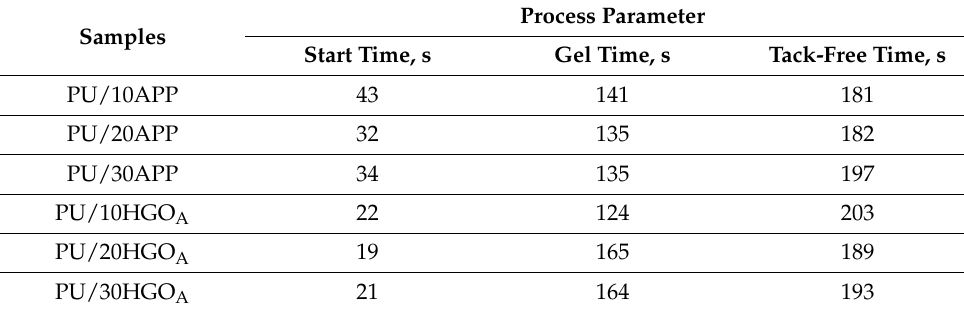
Table 2. Process times for PU/APP and PU/HGO A